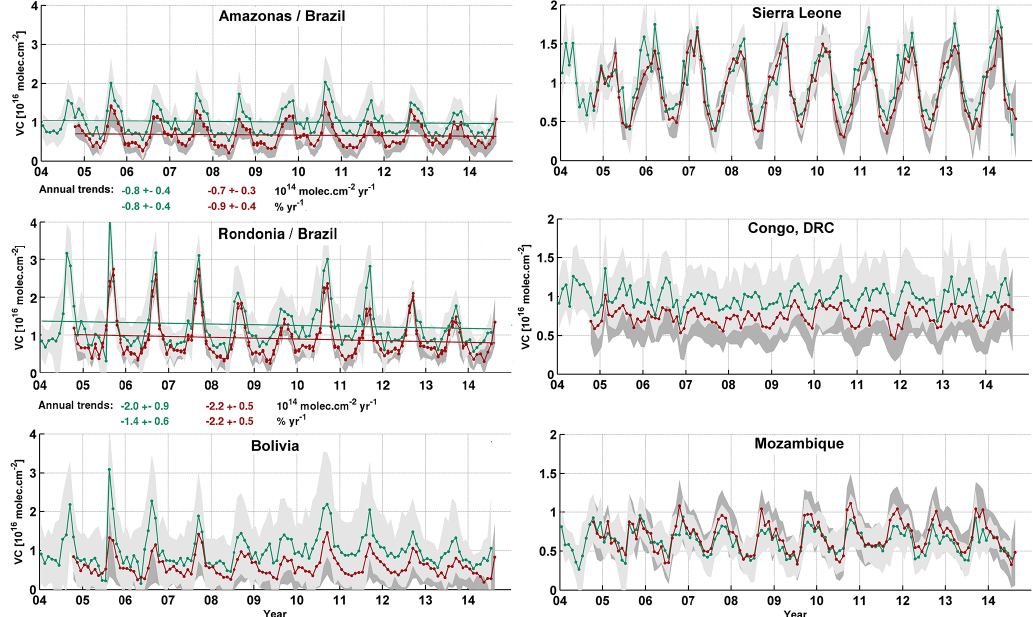
Figure 15. Monthly averaged H 2 CO vertical columns as observed from satellite instruments in South America and Africa. Mid-morning columns (in green) consist of SCIAMACHY (2003–2011), GOME-2A (2007–2013) and GOME-2B (2013– ) measurements, while early afternoon columns (in red) are derived from OMI measurements. If statistically significant, results of the trend analysis are displayed (De Smedt et al.,